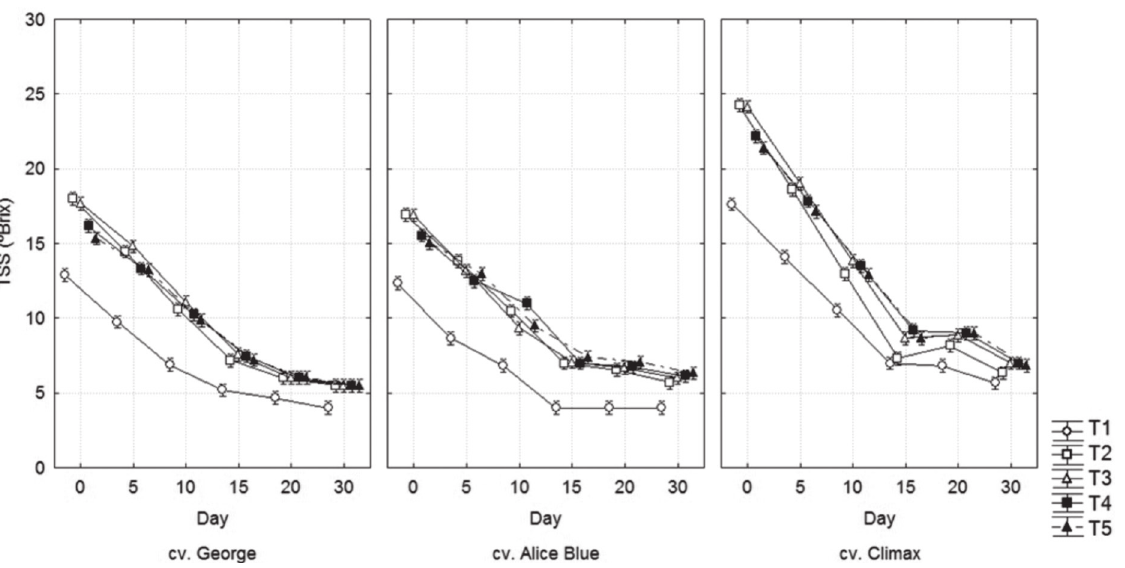
Figure 1 – Fermentation curves for each type of wine throughout time. (T1) control – without sucrose and CaCO + 0.9 gL -1 CaCO , (T3) sucrose + 1.8 gL -1 CaCO 3